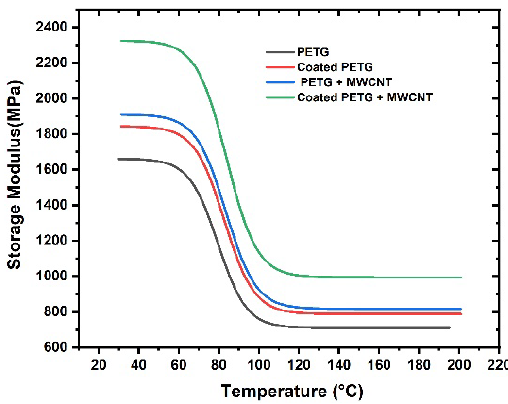
Figure 9. Storage modulus vs. temperature.